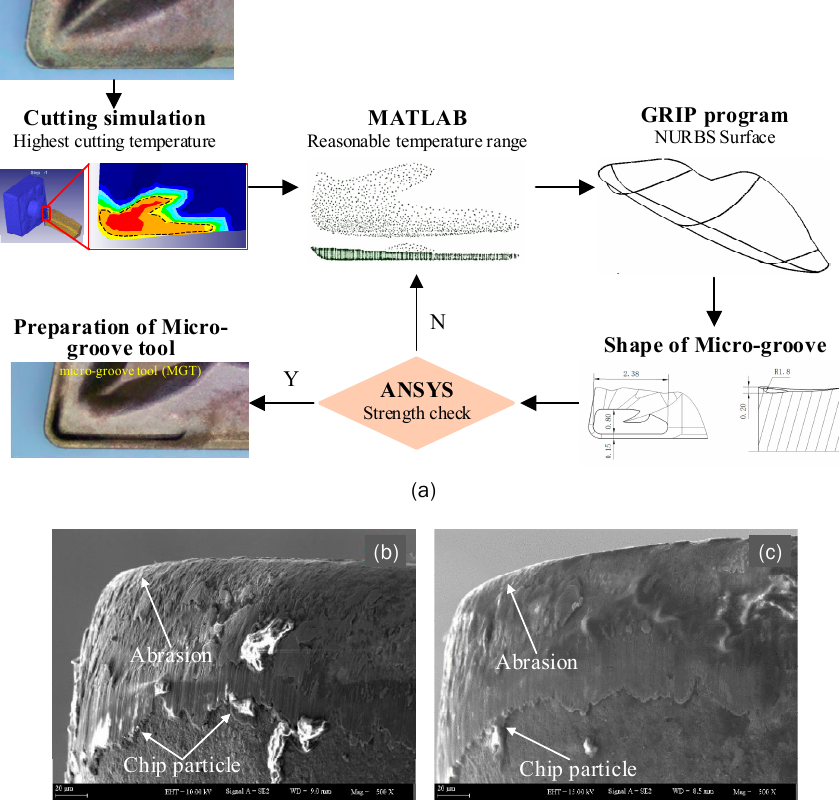
Figure 3. ( a ) Design block diagram of the microgroove tool, microscopic wear pattern of ( b ) the flank face of the conventional tool and ( c )the microgroove tool.